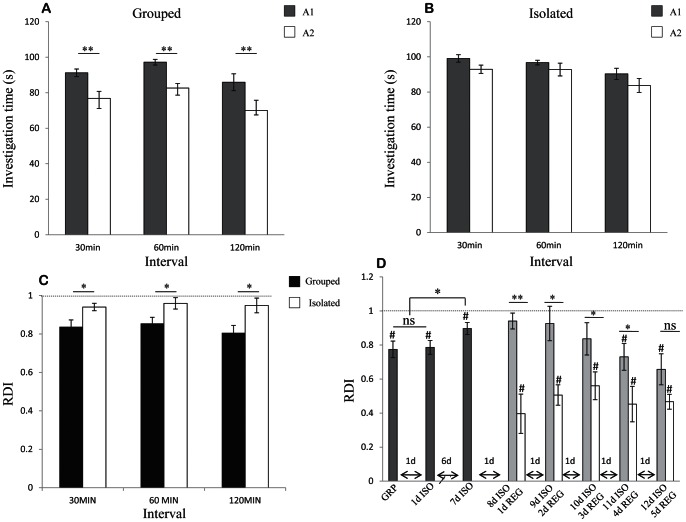
Short-term SRM was also impaired by social isolation (mean±SEM).A) Rats in group housing displayed a significant decrease in SIT during the second 2 min encounter with a juvenile (A2, empty bars) compared to the first (A1, gray bars), regardless of whether the encounters were separated by 30, 60 or 120 min. Paired t-test: ** p<0.01, n = 10 for 30 and 120 min, n = 9 for 60 min. B) Socially isolated rats did not display a significant decrease in SIT during the second 2 min encounter regardless of the interval between the encounters. Paired t-test: p>0.05, n = 10 for 30 and 60 min, n = 12 for 120 min. C) Socially isolated rats (empty bars) showed a significantly higher RDI than animals from group housing (black bars) at all three time intervals. Paired t-test: * p<0.05, Grouped: n = 10 for and 120 min, n = 9 for 60 min. Isolated: n = 10 for 30 and 60 min, n = 12 for 120 min. D) RDI values for two 2 min encounters with the same juvenile 30 min apart. This test was repeated with the same group of adult males (n = 20) while housing conditions were changed, using new stimuli for every session. Short-term SRM was confirmed for every session if a significant reduction in SIT between the first and second encounters was found using paired t-test (# p<0.05). Dark grey bars represent RDI values of 20 adult male rats in group housing (GRP) as well as after 1 day (1 d ISO) and 7 days (7 d ISO) of social isolation. Note that, unlike long-term SRM (Fig. 3A), there was no significant increase in RDI compared to animals from group housing (GRP) after 1 day of social isolation. These animals were then divided into two groups: one group remained in social isolation (ISO, light-grey bars) and the other was returned to group housing (REG, empty bars). Both groups performed the same test on a daily basis. A profound difference between the two groups appeared even 1 day following division (t-test *p<0.05, ** p<0.01), but was gradually reduced. On the last day of the experiment animals in both groups showed short-term SRM, with no significant difference between them.